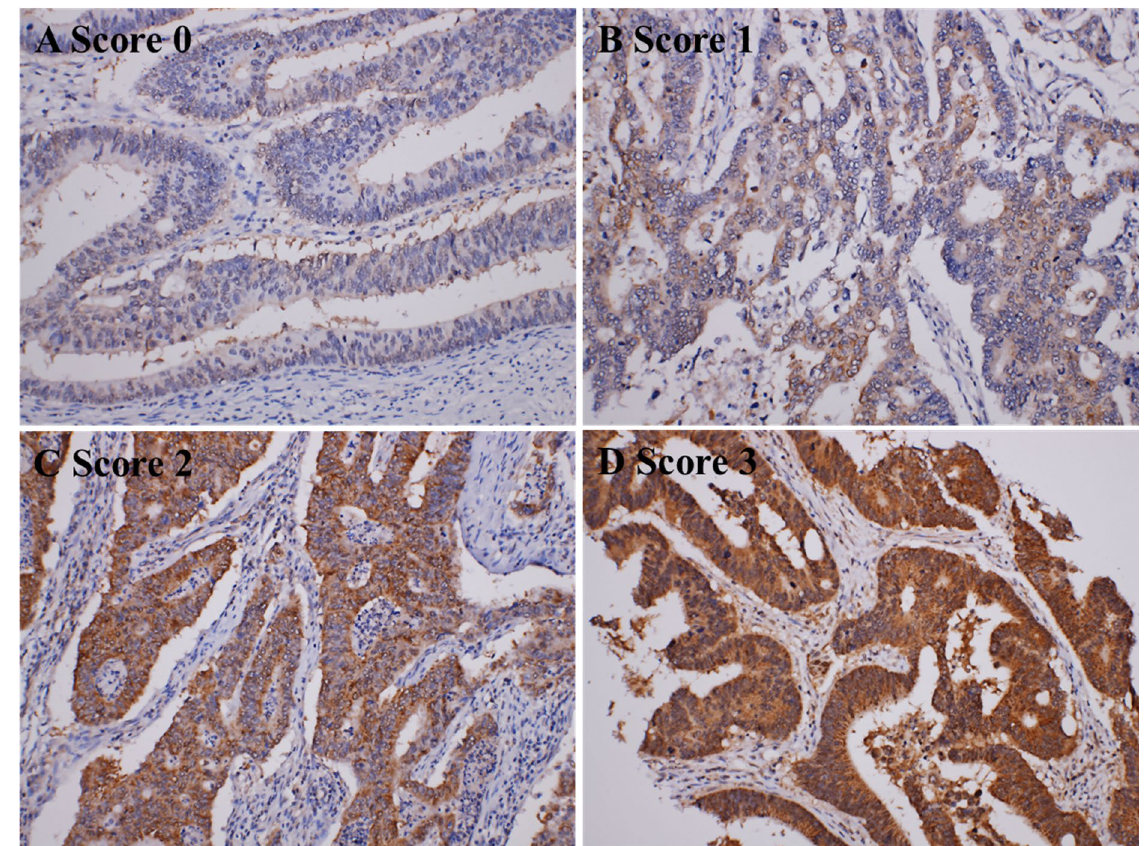
Figure 5. Immunohistochemical representation of the AK5 expression pattern in a CRC tissue microarray. Representative photomicrograph showing different score levels of cytoplasmic AK5 expression in colorectal cancer tissue samples. Original magnification: ×